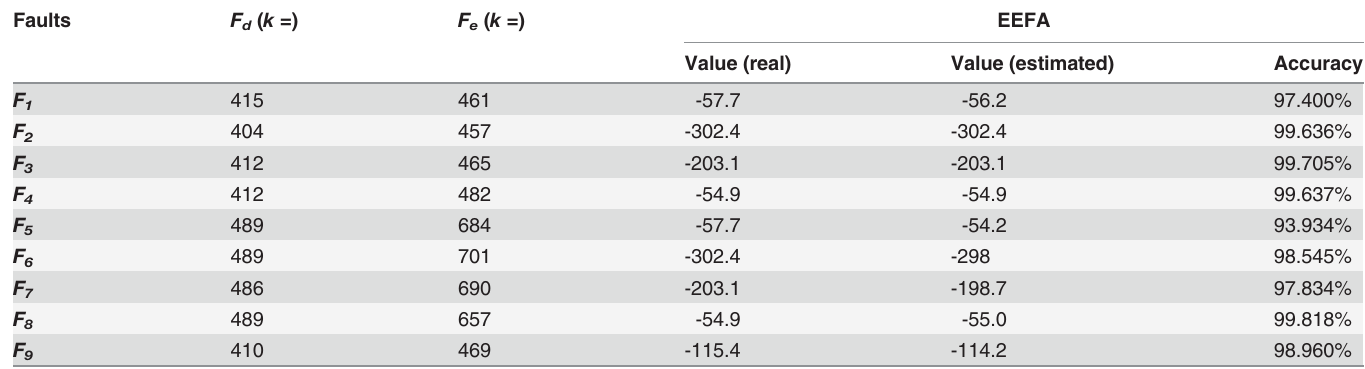
Table 4. Simulation